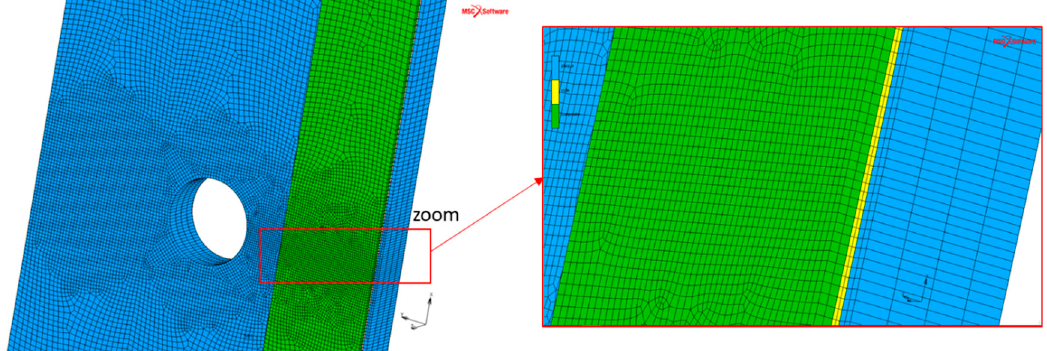
Figure 4. Finite element model of the reinforced plate.